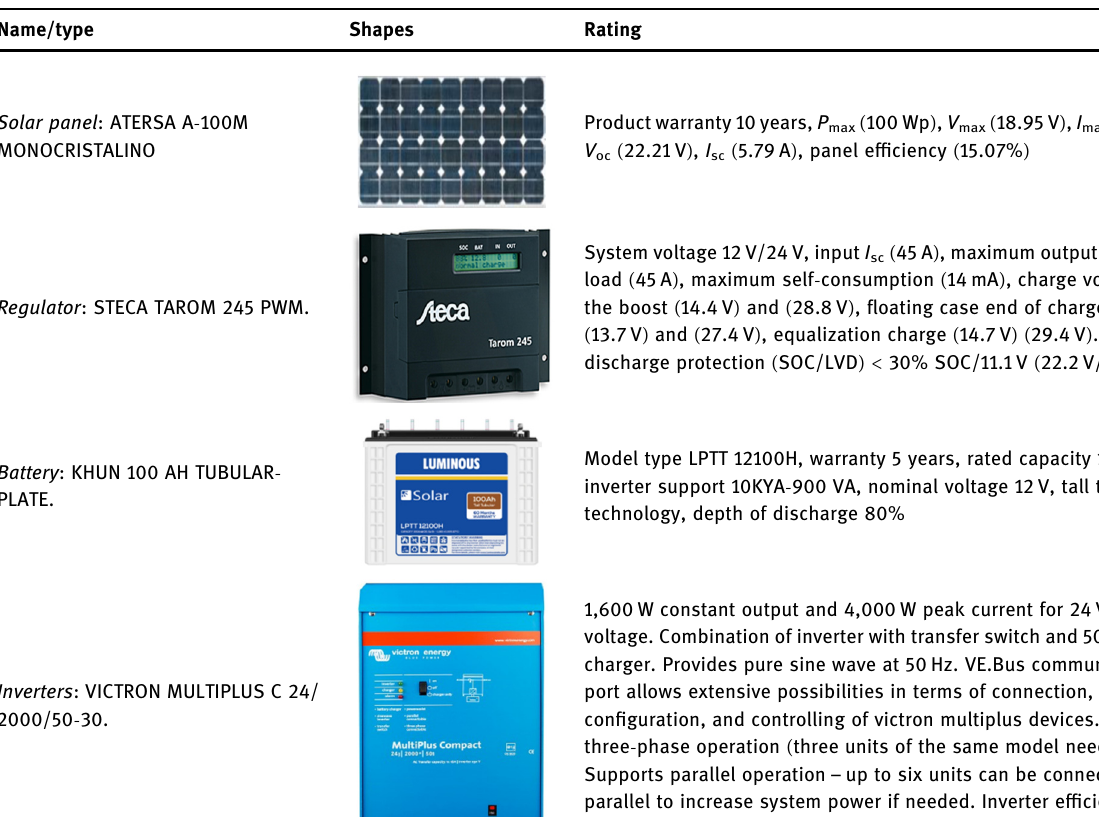
Table 2: Materials of suggested PV system Name/type Shapes Rating